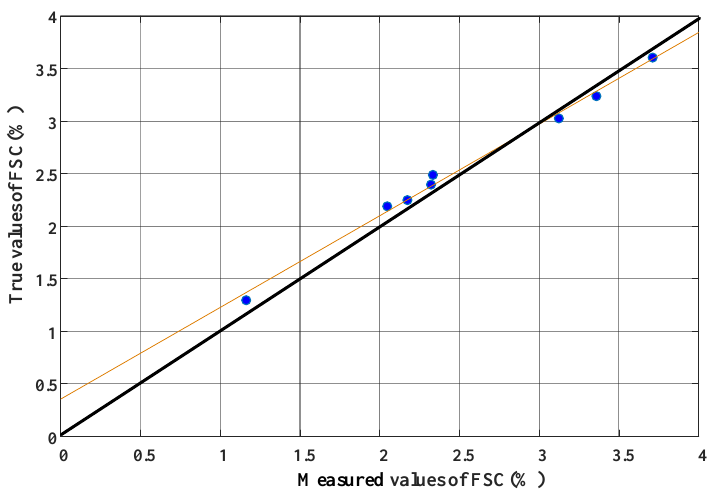
Figure 8. Comparison between the true value of FSC (X-axis) and the measured value of FSC (Y-axis) of 8 ships. The orange, black lines and blue dots represent the actual fitted curve, theoretical fitted curve and measured value of FSC, respectively.